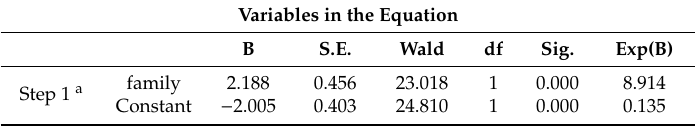
Table A2. The fit of the binary Logistic regression and variables in the model.